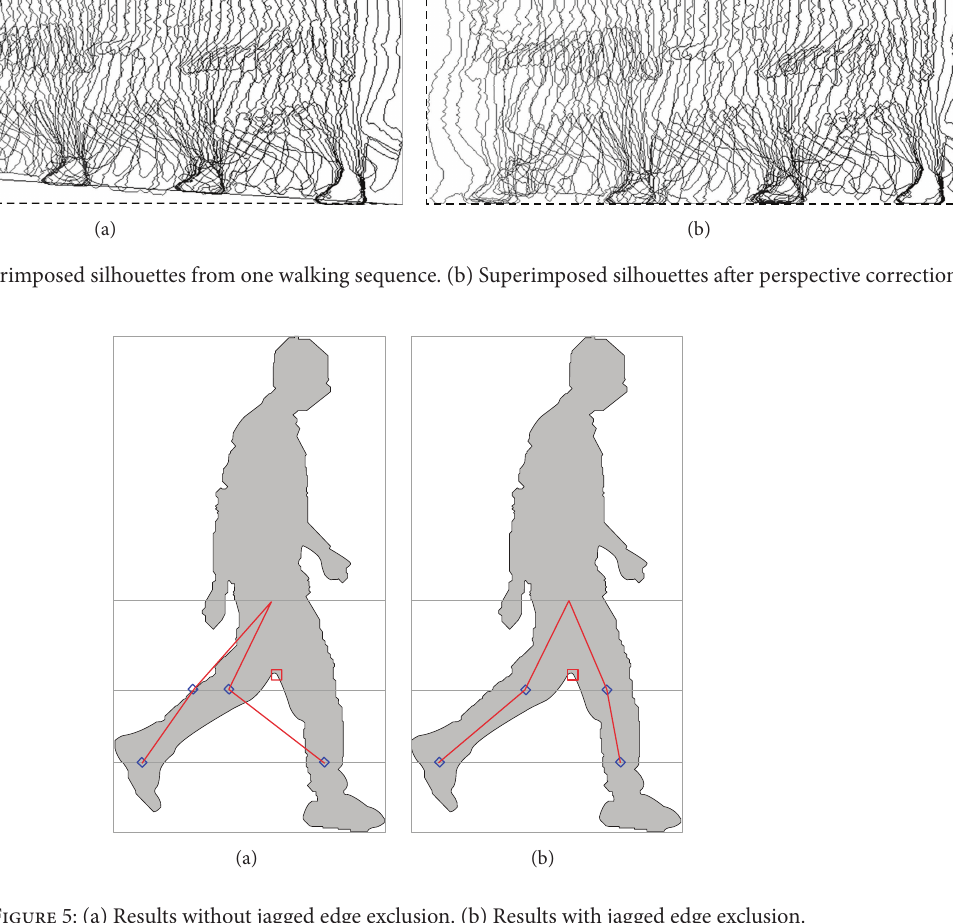
Figure 5: (a) Results without jagged edge exclusion. (b) Results with jagged edge